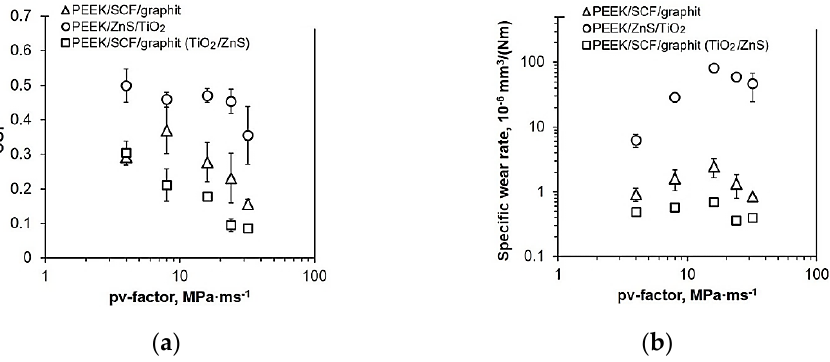
Figure 19. The mean CoF ( a ) and specific WR ( b ) levels of the PEEK-based composites under different P · V parameters at various sliding stages. Figure is reproduced with permission from reference [151].